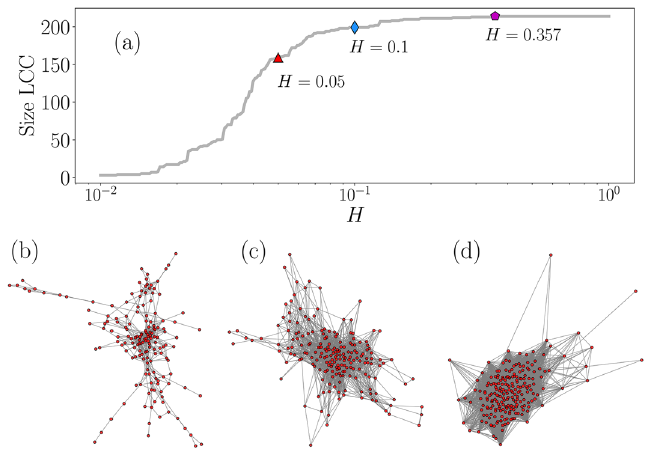
Figure 5. Similarity networks in the activity of vehicles in the BRT system Metrobús. ( a ) Size of the largest connected component (LCC) as a function of the threshold value H for the similarity between segments. Three particular LCCs obtained for H = 0.05 , H = 0.1 and H = 0.357 are presented in panels ( b )–( d ), respectively. H = 0.357 is the lowest value of H that produces a connected network including the 214 segments. All